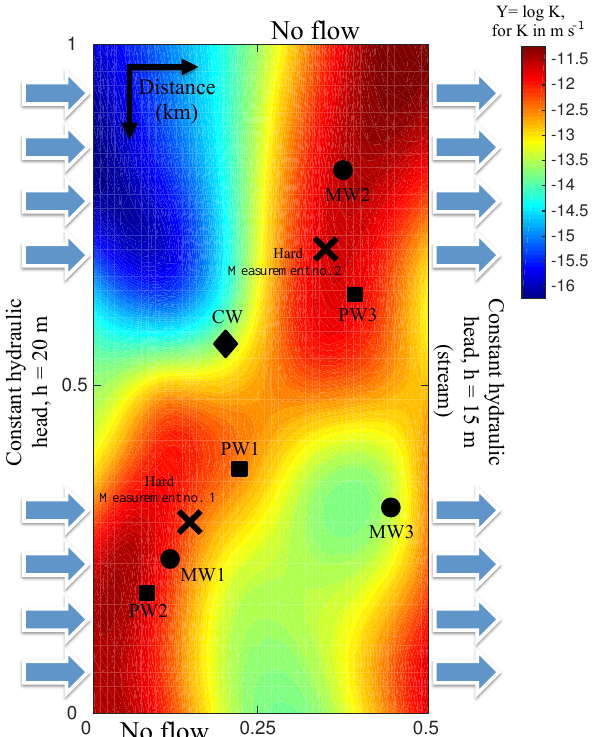
Figure 1. Plan view of the conceptual model for the 2-D transient groundwater flow problem. East and west boundaries ( x direction) are Dirichlet with a given prescribed hydraulic heads. North and south boundaries ( y direction) are impermeable (no flow bound- aries). The reference log-conductivity field was obtained using the sequential Gaussian simulation code (Gómez-Hernández and Jour- nel, 1993). A Gaussian variogram model is considered with a geo- metric mean of 10 − 13 ms − 1 , a variance of Y = log K equal to 1.5, and range equal to 250 and 500m in the x and y directions, re- spectively. The black squares represent the pumping wells, whereas the black circles denote the position of three monitoring wells. The black diamond is a control well. The two black crosses correspond to the locations where the conductivity values were used to condi- tion the geostatistical